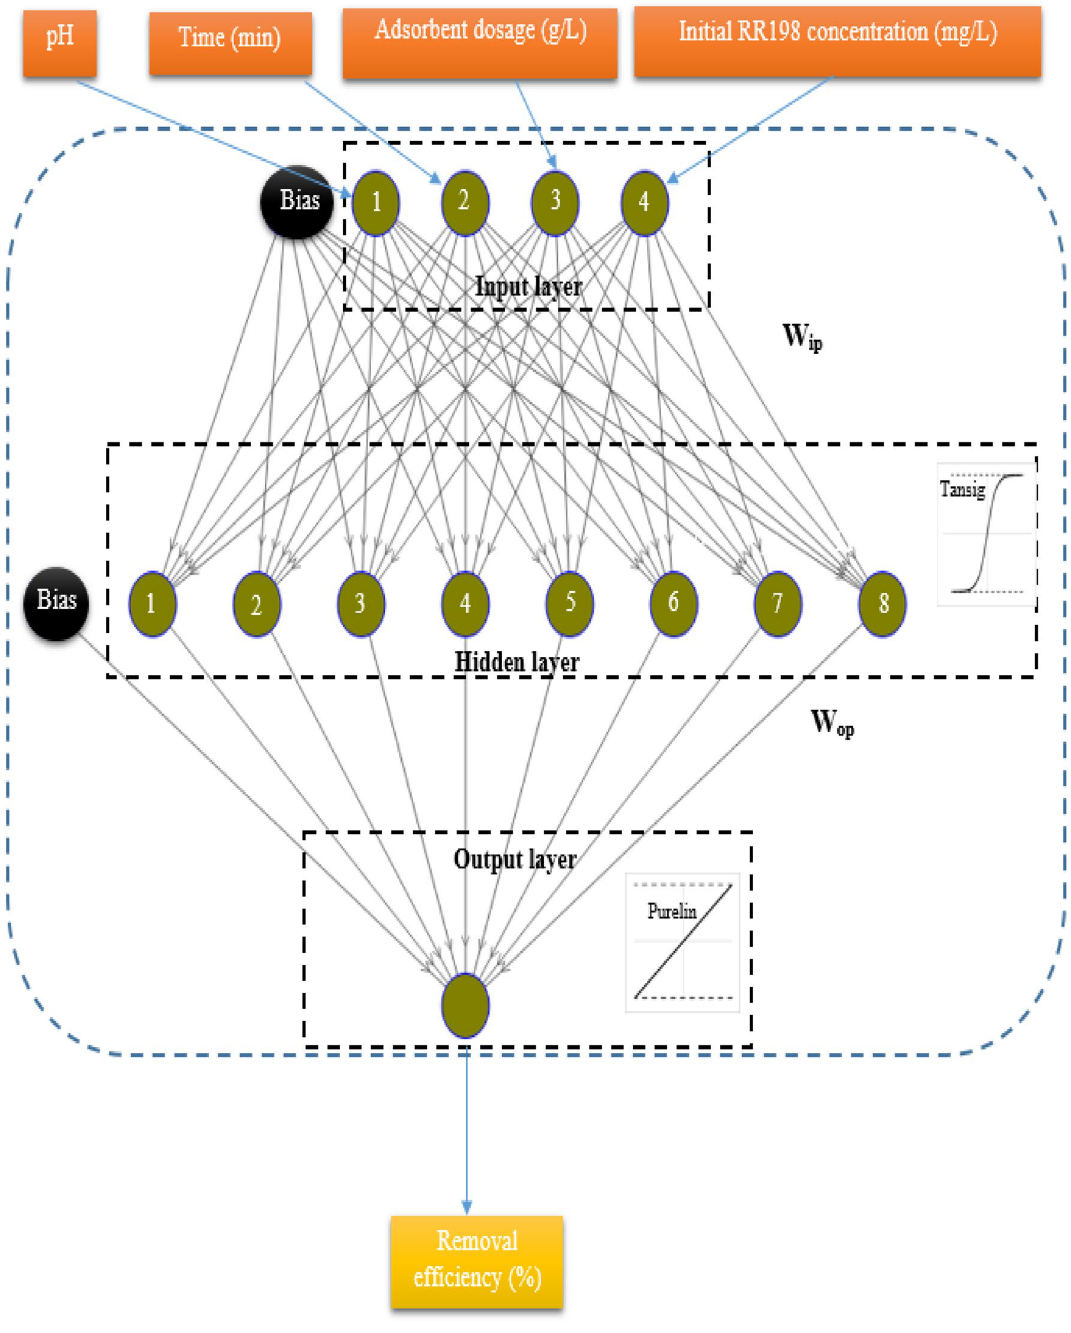
Figure 4. The neural network architecture for a three-layer ANN model with 4-5-1